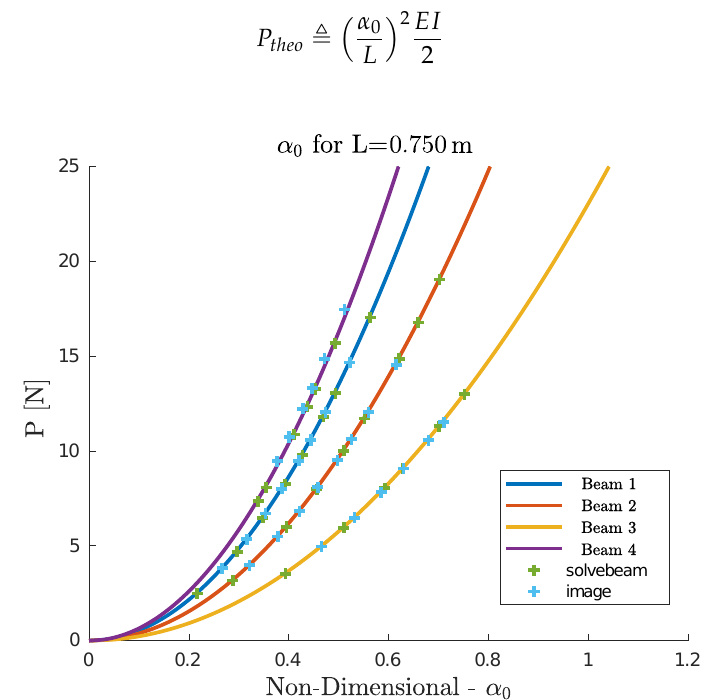
Figure 7. Contacted force P versus nondimensional parameter for beam length of 0.75 m.